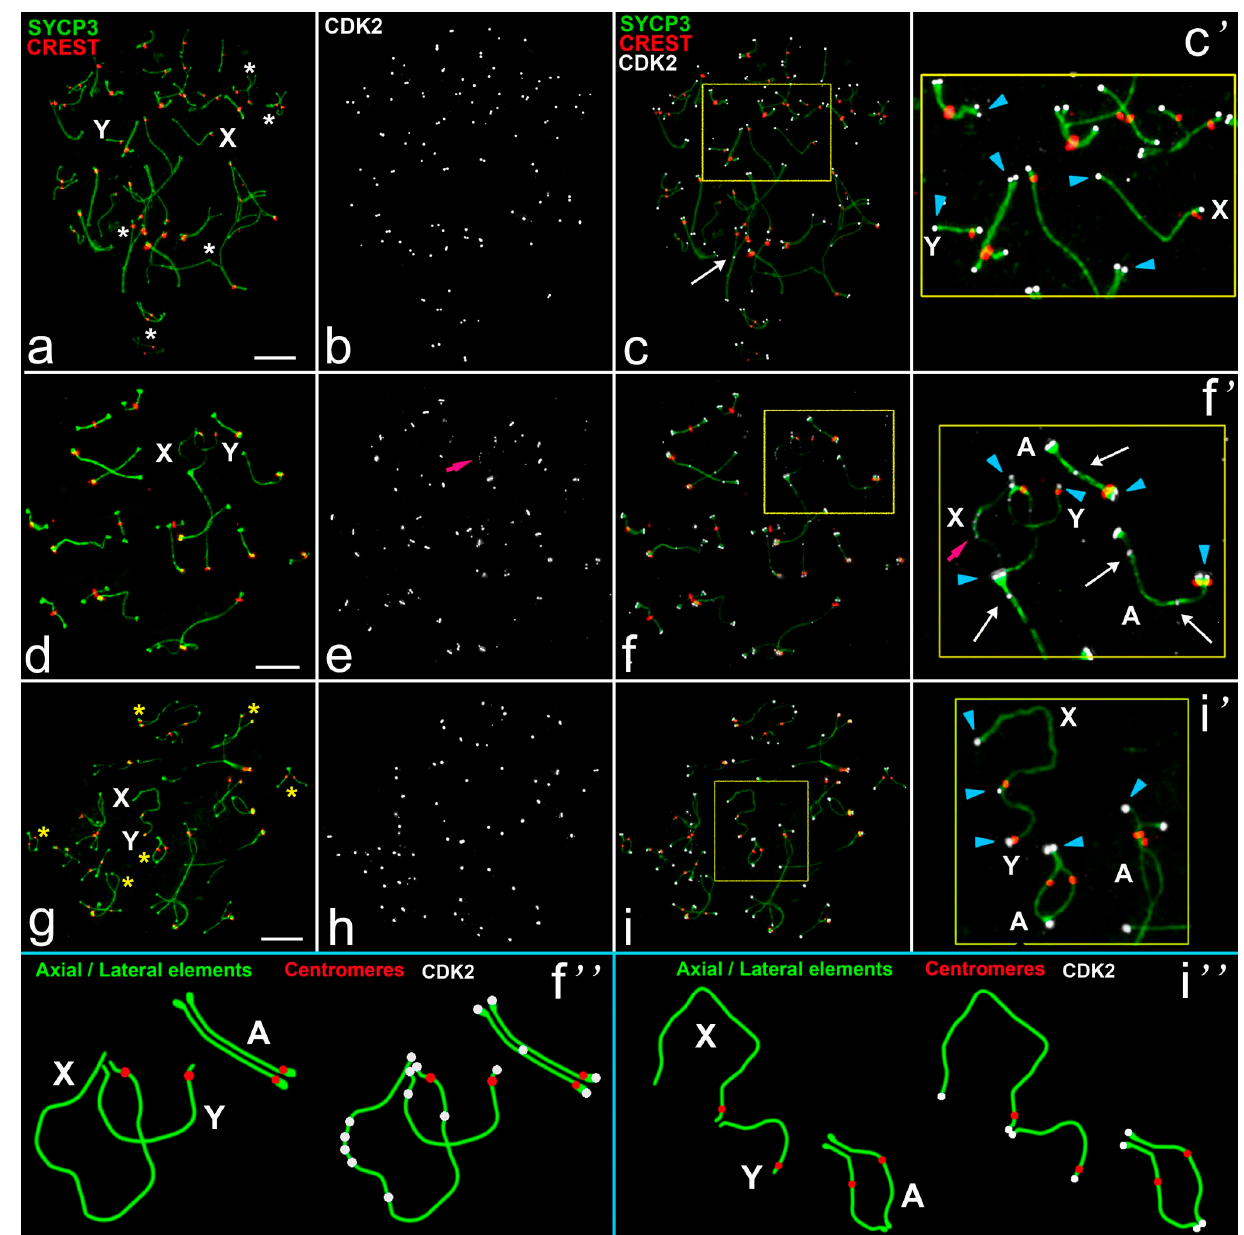
Figure 1. CDK2 localization in meiotic chromosomes of the rat R. norvegicus . SCs were immunostained using antibodies to SYCP3 protein (green), centromeres using antibodies to proteins of kinetochores (CREST, red), and CDK2 kinase using antibodies to CDK2 (white). Blue arrowheads point to the telomeric localization of Cdk2. White arrows point to the interstitial CDK2 location. Pink arrows outline numerous CDK2 signals in asynaptic segments of the sex bivalent. A—autosomal bivalents. XY—sex chromosomes. ( a – c ) Mid zygotene. Asynapsis in several bivalents is marked as a white stars; ( d – f ) Mid pachytene; ( g – i ) Diplotene. Desynapsis in several bivalents is marked as yellow stars. ( c’ , f’ , i’ )—enlarged parts of the relevant photos. ( f’ , i’ )—schemes of some meiotic chromosomes in ( f’ , i’ ). Scale bar ( a – i ) = 5 µm.